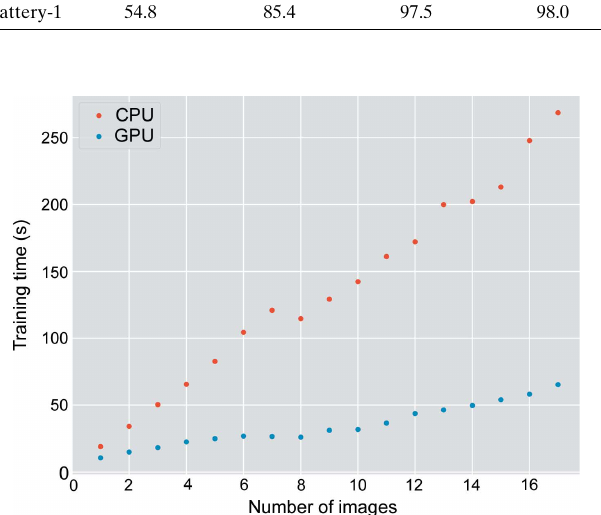
Figure 4 Training time performances as a function of the number of training images based on the gradient boosting algorithm.